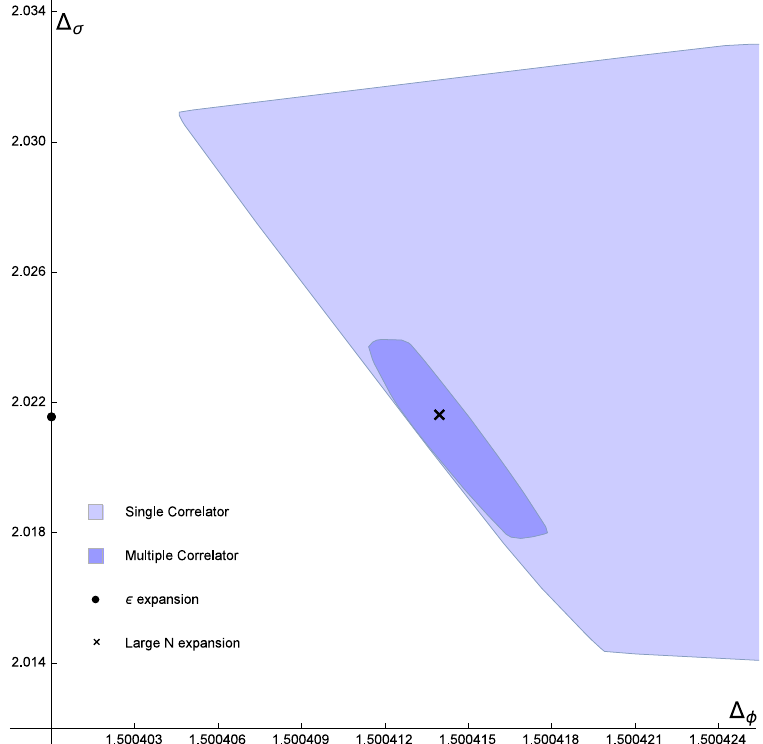
Figure 1 . Bounds on the conformal dimensions ((cid:1) (cid:30) ; (cid:1) (cid:27) ) in the interacting 5 D O (500) CFT. The colored regions represent the conformal dimensions allowed by conformal bootstrap. Speci(cid:12)cally the light blue region is obtained from single correlator bootstrap, while the dark blue island is isolated through bootstrapping the multiple correlators. We used the derivative at order (cid:3) = 19 and spins S (cid:3)=19 in the numerical calculations. Besides, we assumed a gap (cid:1) (cid:3) = 3 : 965 in the S-channel. An S; 0 extra gap (cid:1) (cid:3) = 5 has been used in the V-channel for bootstrapping multiple correlators. The V; 0 black dot and cross relate to the predictions from (cid:15) expansion and large N expansion,